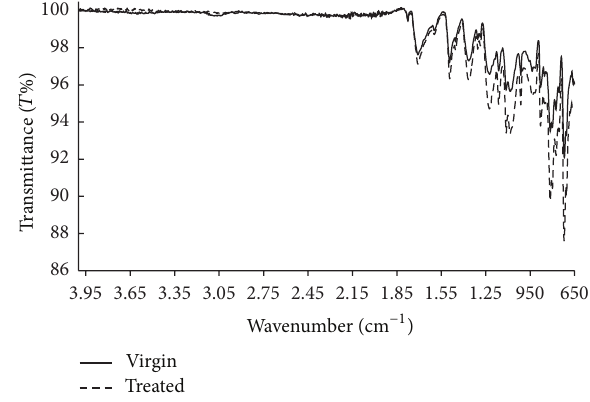
Figure 6: The FTIR spectrum of virgin and short-time DBD treated